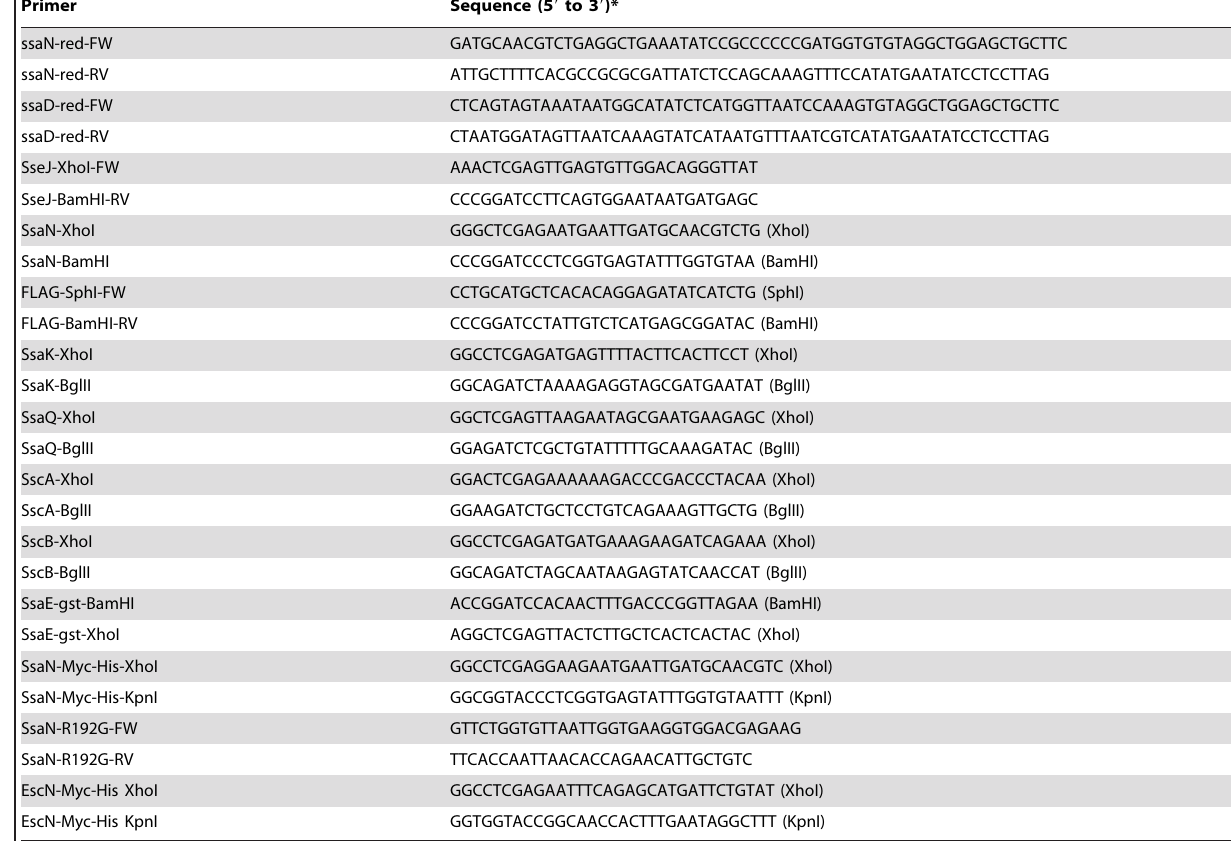
*Letters in bold indicate restriction site shown in parenthesis.